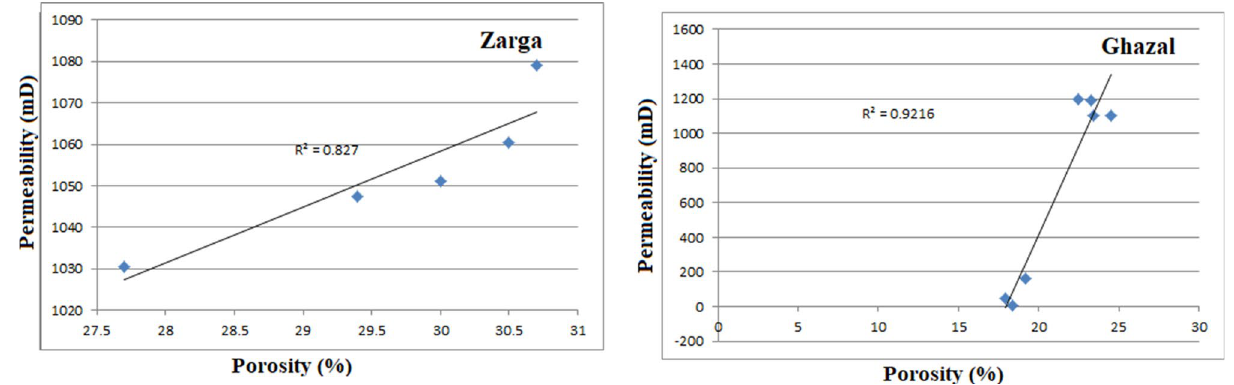
Figure 16. Cross-plot showing a positive correlation between porosity and